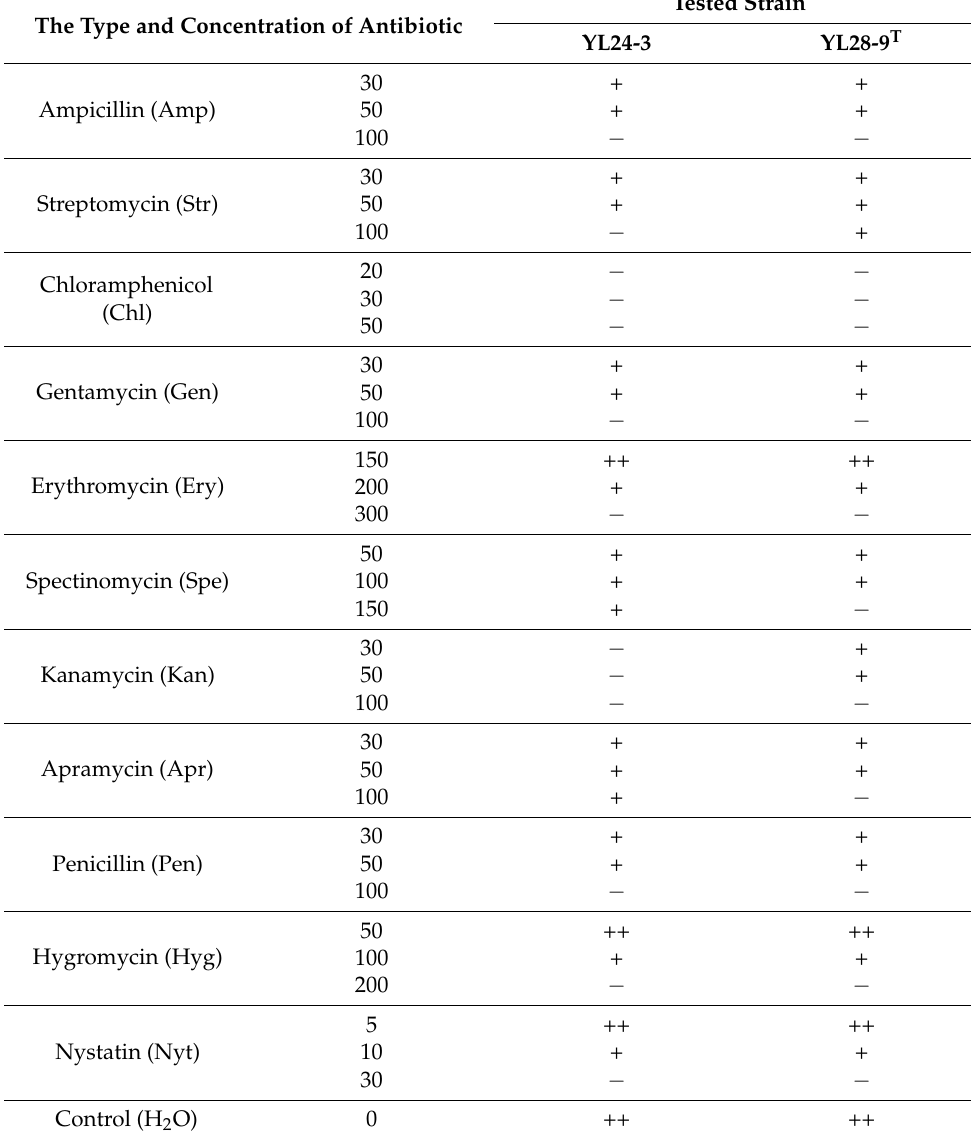
Table 2. The growth status of the tested strains under different concentrations of antibiotics. The Type and Concentration of